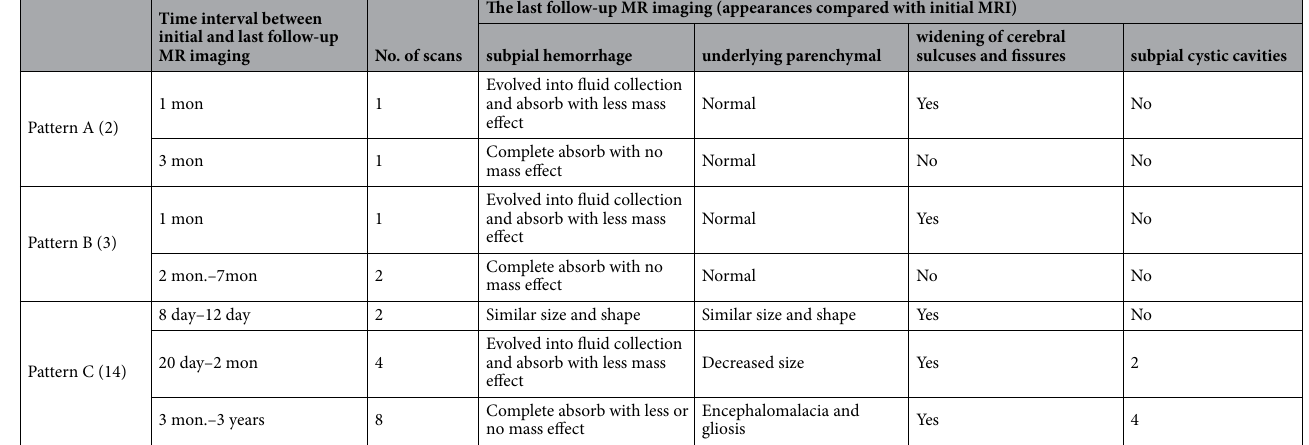
Table 4. The last follow-up MR imaging of subpial hemorrhage in